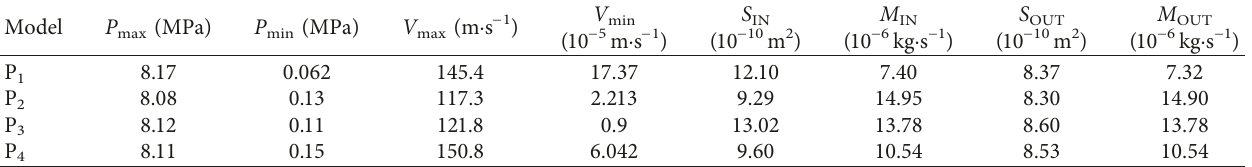
Table 7: Simulated results of seepage parameters in four models under a medium inlet pressure of 8.1 MPa.